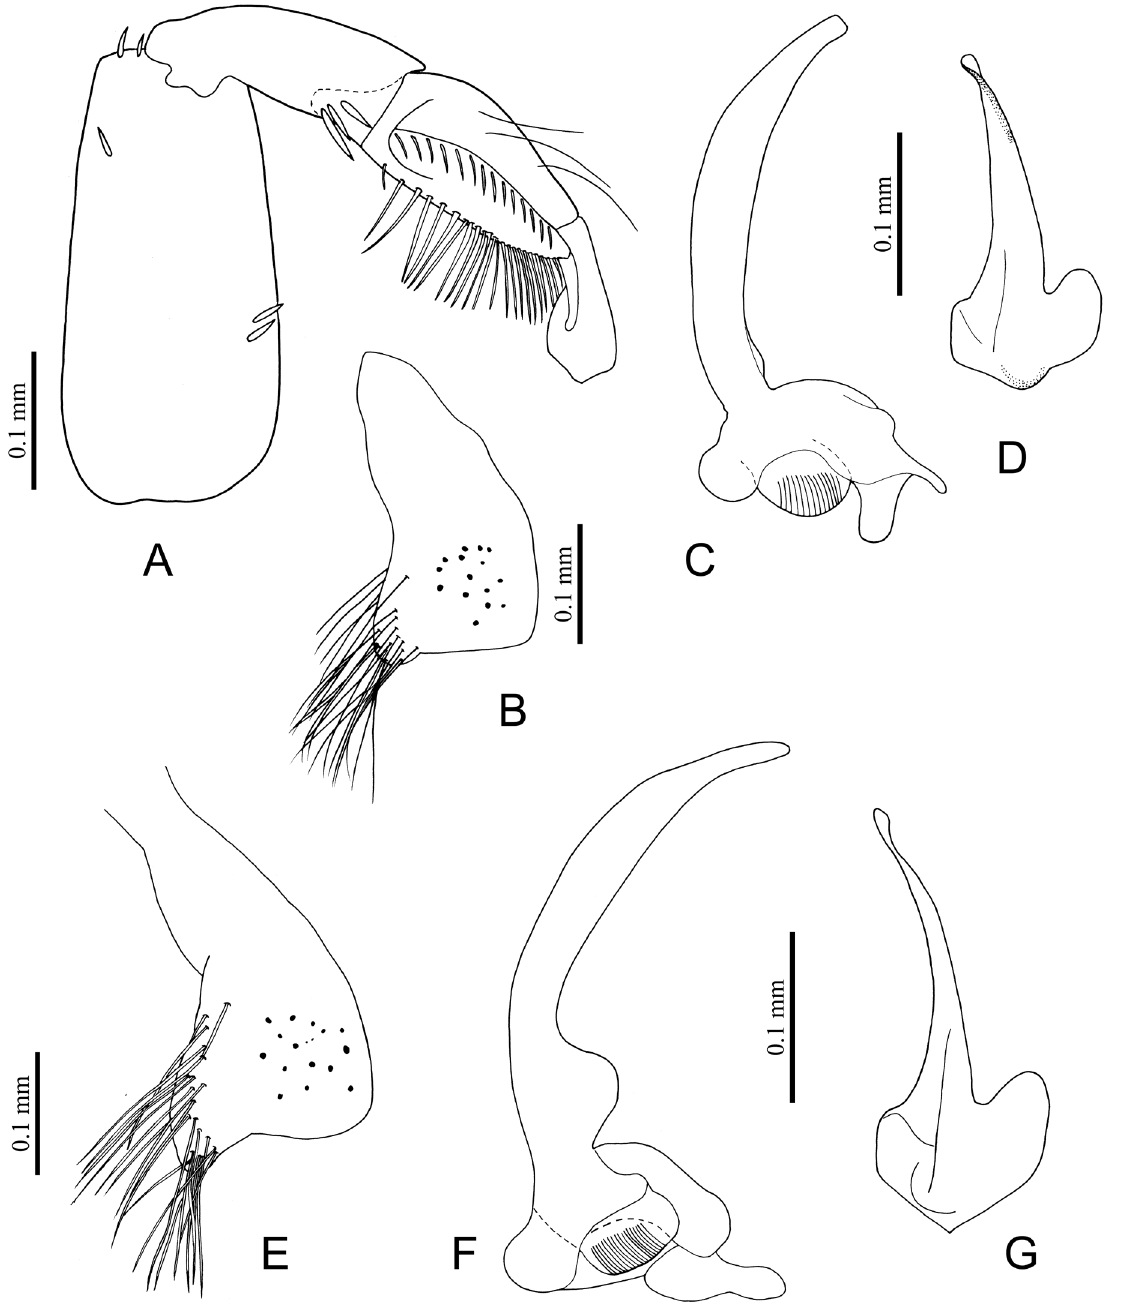
Fig. 23. Morphological features of species of Micronecta Kirkaldy, 1897, ♂♂. A–D . M. melanochroa Nieser, Chen & Yang, 2005 (ZVNU). E–G . M . polhemusi Nieser, 2000 (ZVNU). A = fore leg; B, E = free lobe; C, F = right paramere; D, G = left